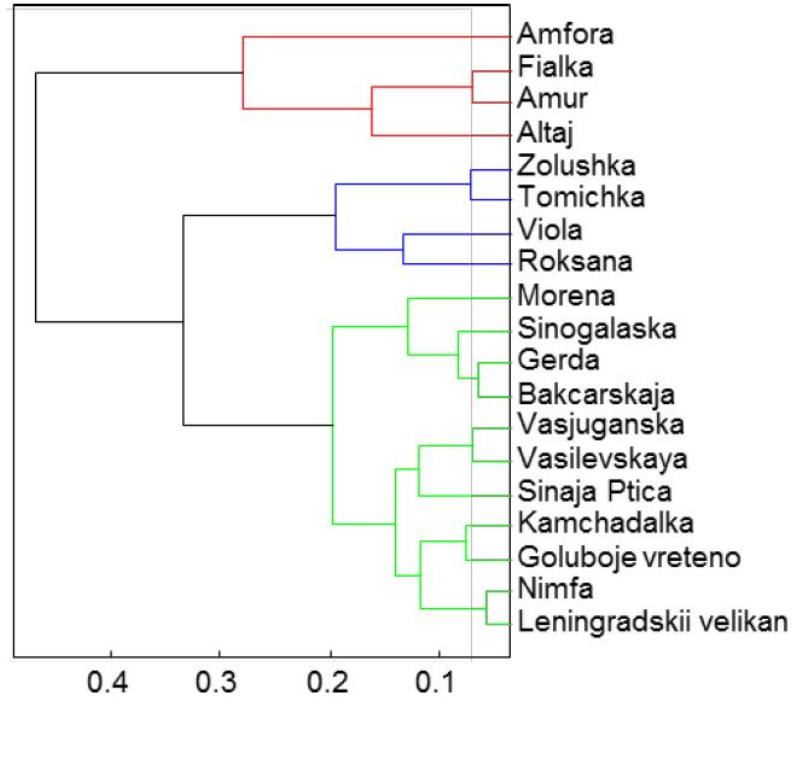
Figure 8. The cluster analysis of mineral compounds represented by three principal